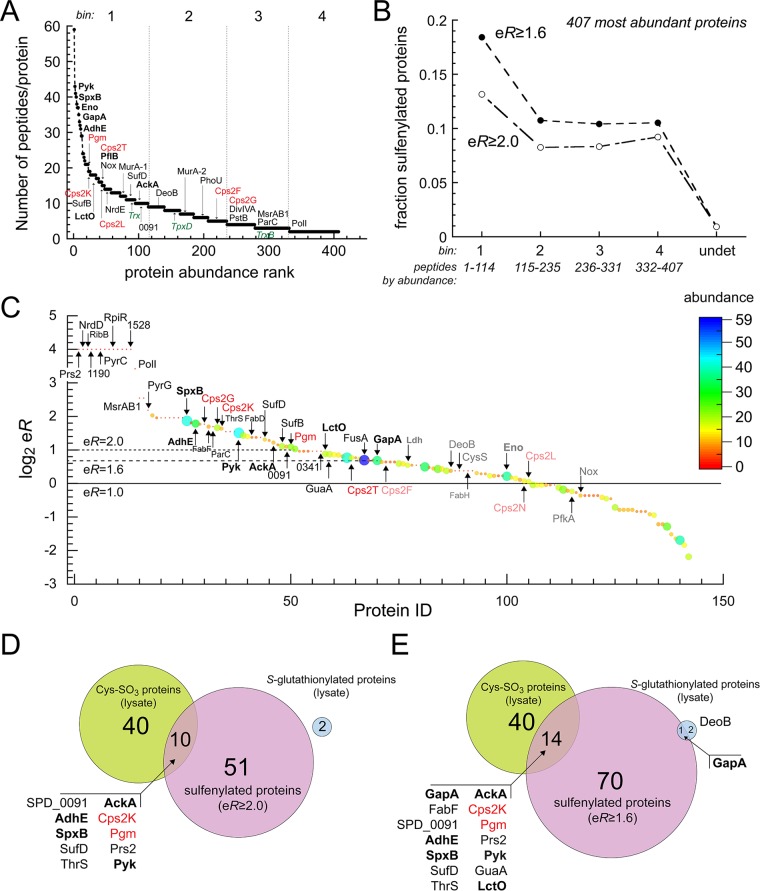
Proteomic profiling of sulfenylation by endogenous H2O2 in S. pneumoniae cells. (A) The 407 total peptides confidently identified (≥2 unique peptides per protein) in an unenriched total cell lysate of S. pneumoniae D39 are ranked according to unique peptide abundance (62) and binned into the four bins numbered at the top (also see panel B). A subset of proteins are highlighted by protein identification. Boldface black indicates enzymes of glycolysis and the pyruvate node (Fig. 1), red indicates enzymes of capsule biosynthesis (Fig. 6), and green indicates thioredoxin (Trx), thioredoxin reductase (TrxB), and thiol peroxidase (TpxD), not detected as sulfenylated and shown for reference. (B) The fraction of sulfenylated proteins as a function of protein abundance for enrichment levels (eR) of 1.6 (dashed line; 75.6% confidence [Fig. S5]) or 2.0 (dot-dash line; 80.6% confidence [Fig. S5]). Bins: 1, 10 to 59 unique peptides per protein (114 total proteins); 2, 5 to 9 unique peptides per protein (121 total proteins); 3, 3 to 4 unique peptides per protein (96 total proteins); 4, 2 unique peptides per protein (76 total proteins). undet, undetected in cells. See Table S2A and B for a complete list of all 407 most abundant proteins. (C) Plot of enrichment ratio (eR) versus arbitrary Protein ID index, ranked from largest to smallest values of log2 eR. Proteins detected only in the DAz-2-enriched eluant and not in the total lysate were arbitrarily assigned a log2 eR value of 4.0 (13 proteins). Lines corresponding to eR values of 1.0 (no enrichment), 1.6 (all proteins enriched relative to GapA, a known sulfenylation target), and 2.0 are shown for reference. Selected proteins are indicated. Boldface black indicates enzymes of glycolysis and the pyruvate node (Fig. 1), and red indicates enzymes of capsule biosynthesis (Fig. 6). Each protein ID symbol is colored and sized according to cellular abundance (number of unique peptides recovered as proxy for abundance). See Table S2A and B for a complete list of all 142 Cys-containing proteins detected. Venn diagrams compare the number of sulfenylated proteins in panels D (eR ≥ 2.0) and E (eR ≥ 1.6) versus the number of Cys-sulfonylated proteins and number of S-glutathionylated proteins in an unenriched total lysate. All 10 (D) and 14 (E) sulfonylated proteins are identified with high confidence as sulfenylated in cells (eR ≥ 1.6), as is one of the two S-glutathionylated targets (GapA) (Table S2D and E). Names of proteins are colored as in panel C.